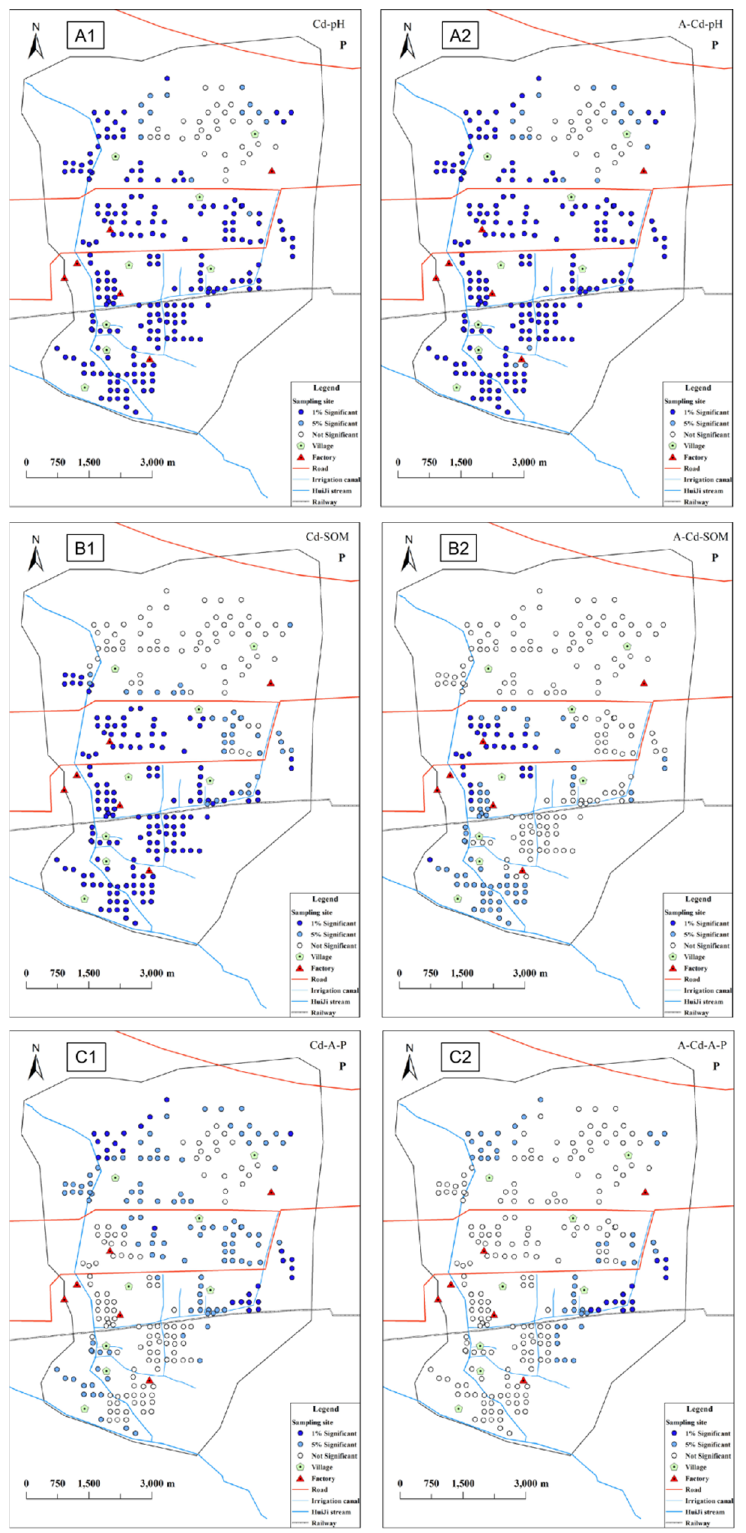
Figure 5. Spatial distribution of local significance values of correlation between Cd and soil properties. ( A1 ) shows the spatial distribution for the significant levels of the correlation between T-Cd and pH; ( A2 ) for the significance between A-Cd and pH; ( B1 ) for T-Cd and SOM; ( B2 ) for A-Cd and SOM; ( C1 ) for T-Cd and A-P; ( C2 ) for A-Cd and A-P.